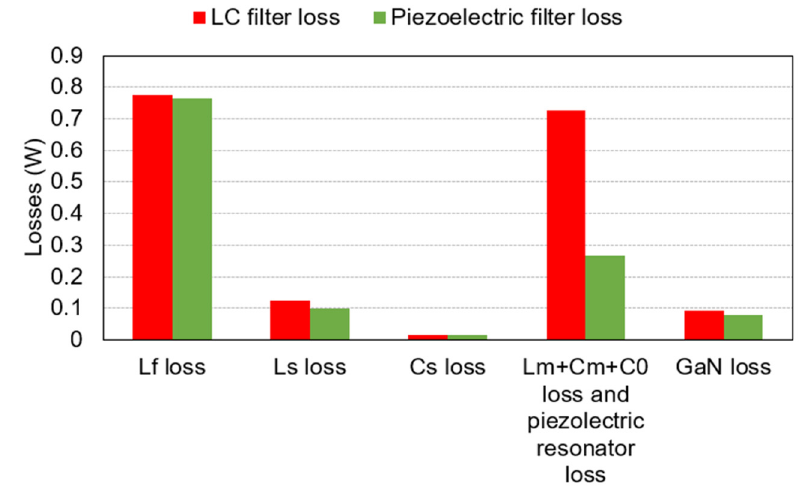
Figure 13. Distribution of losses in each prototype.